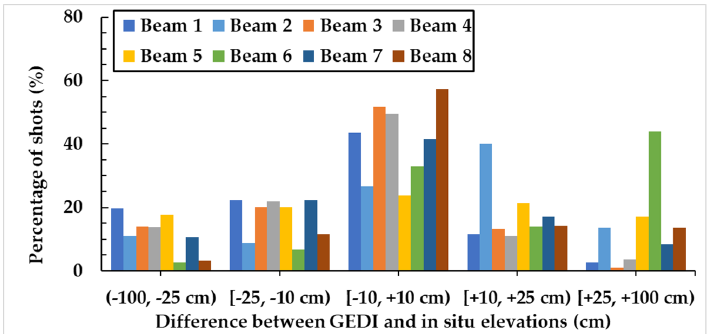
Figure 6. Percentage of GEDI shots for each beam with the difference between GEDI and in-situ elevations (D) grouped intro 5 intervals: (−100, −25) [−25, −10), [−10, +10), [10, +25), and [25, +100) cm.